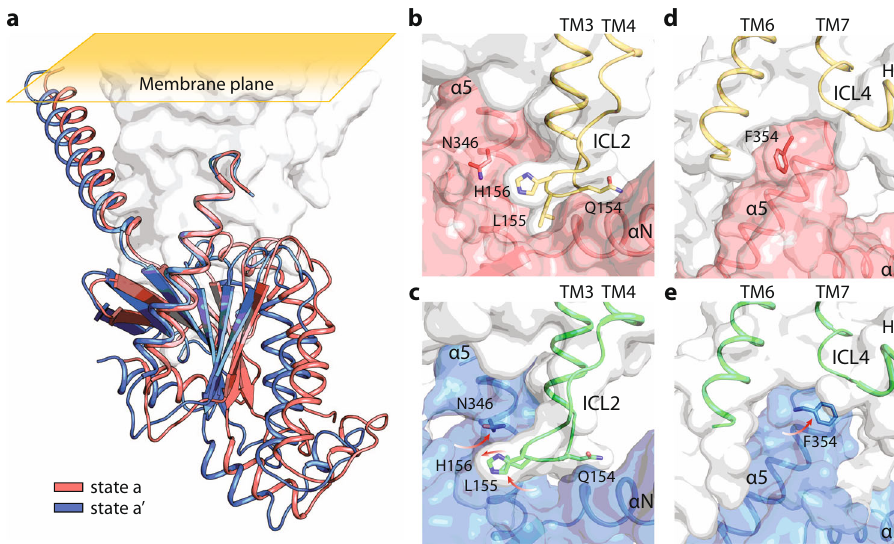
Fig. 8 The dynamic interactions between LPA 1 and G α i . a The superposition of State a and a ’ in the fi rst component of 3DVA with the receptor shown in white surface and G βγ removed for clarity. b, c Key residues for the interactions among ICL2, TM4 and TM5 of the receptor and the α 5 helix of G α i are shown in sticks for comparisons overlaid with the surface view of G α i . d , e Comparison of the side chain rotamers of F354 at the two